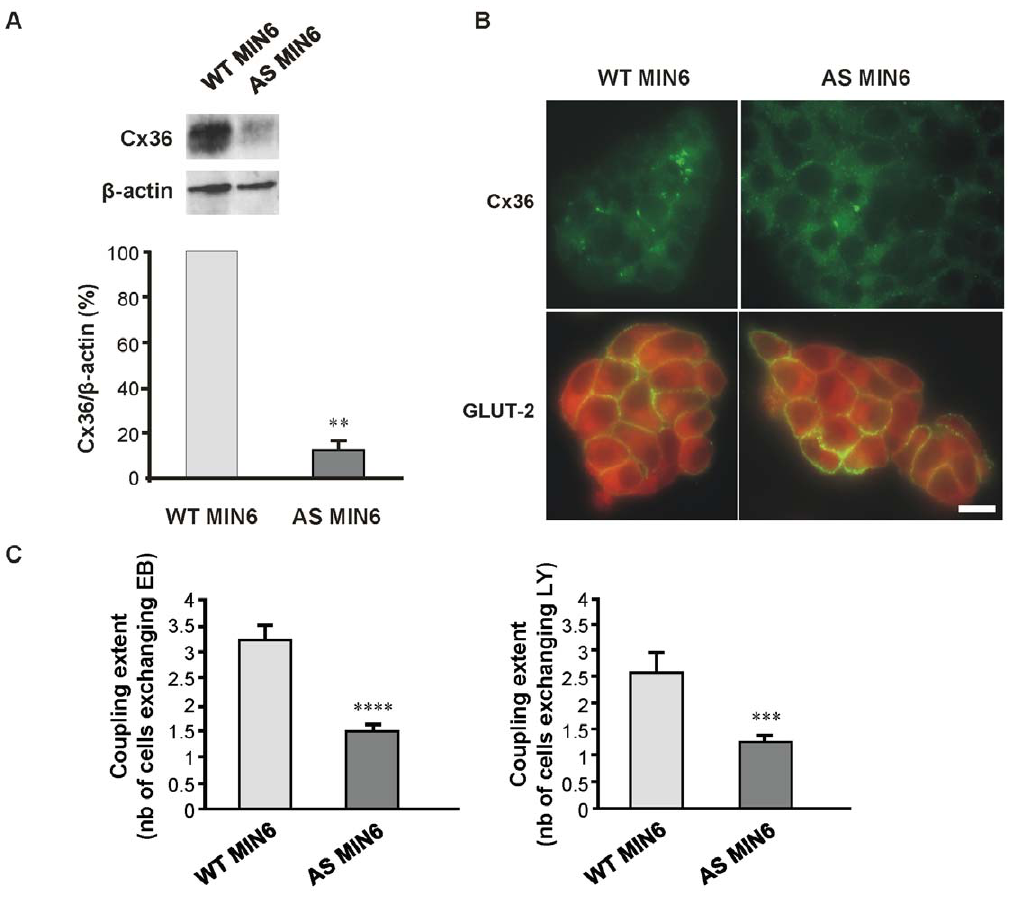
Figure 1. Wild type and Cx36-antisense MIN6 cells differ by the expression of Cx36 and cell-to-cell coupling. ( A ) Immunoblots of total cell extracts showed that AS Cx36 ( gray bar ) in comparison to WT MIN6 cells ( light gray bar ) featured a 80% reduction in Cx36 levels, relative to those of b smooth muscle actin. Data are means + SE of three independent experiments. **p , 0.01; ( B ) Immunostaining showed that the expression Cx36, but not of GLUT-2, was lower in AS Cx36 than in WT MIN6 cells. Bar, 10 m m; ( C ) Microinjection of either EB or LY showed that AS MIN6 ( gray bar ) were significantly less coupled than WT cells ( light gray bar ). Values are means + SE of four independent experiments. ***p , 0.001. The global evaluation of coupling, provided by computing a total coupling index, showed that the coupling of AS MIN6 was , 3% of that of WT cells.